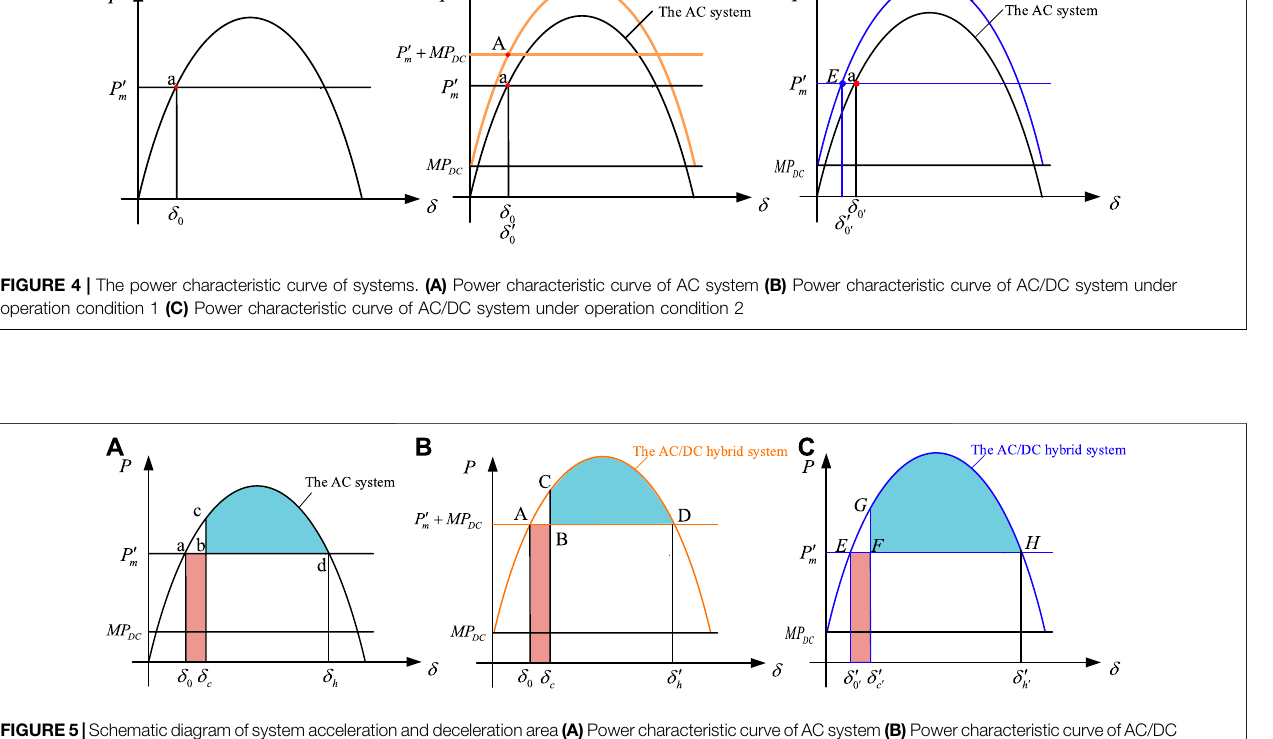
FIGURE5| Schematicdiagramofsystemaccelerationanddecelerationarea (A) PowercharacteristiccurveofACsystem (B) PowercharacteristiccurveofAC/DC system under operation condition 1 (C) Power characteristic curve of AC/DC system under operation condition 2.